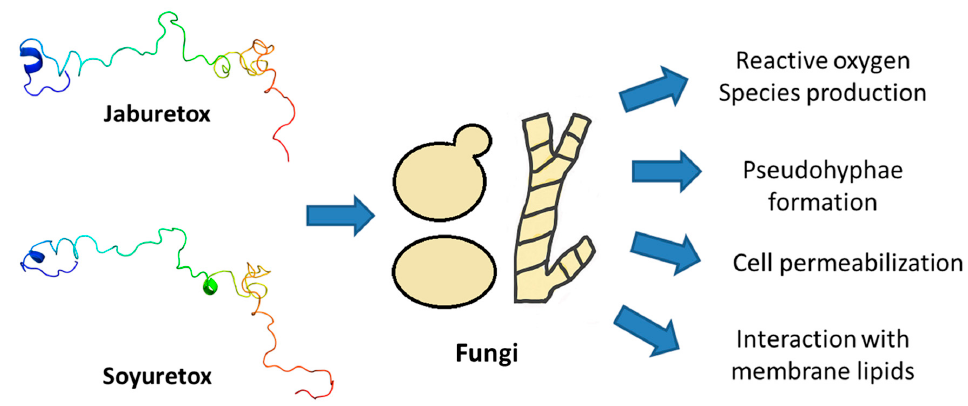
Figure 4. Schematic representation of the antifungal effects of Jaburetox and Soyuretox against filamentous fungi and filamentous fungi and yeasts.